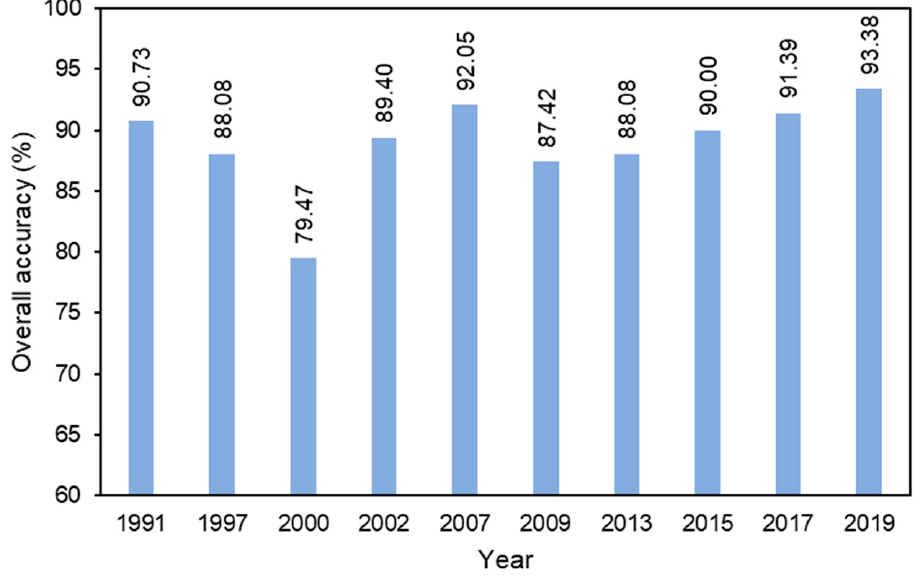
Figure 3. The overall accuracy of land use classifications.